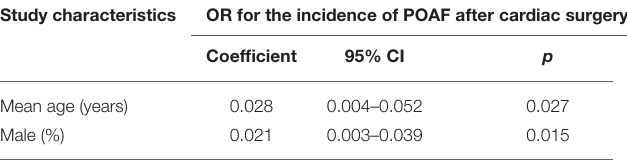
TABLE 3 | Results of univariate meta-regression analysis.